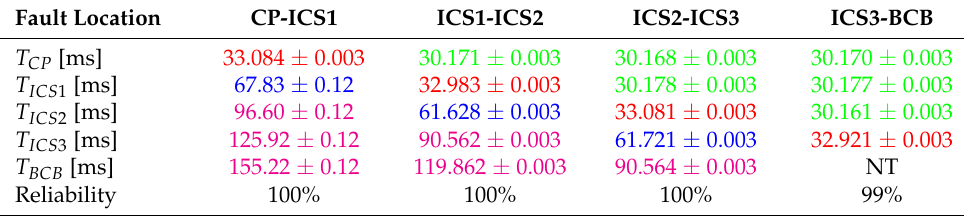
Table 6. Results obtained with SF = 8 and BW = 250 kHz.